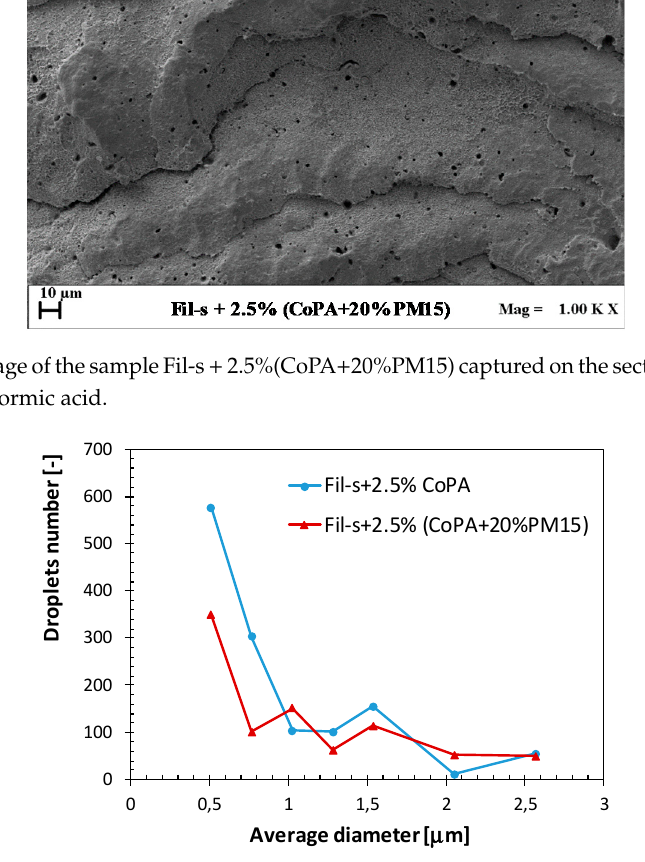
Figure 9. Particle size distribution of the CoPA dispersed phase for the unfilled and nanocomposite Fil-s / CoPA blends.